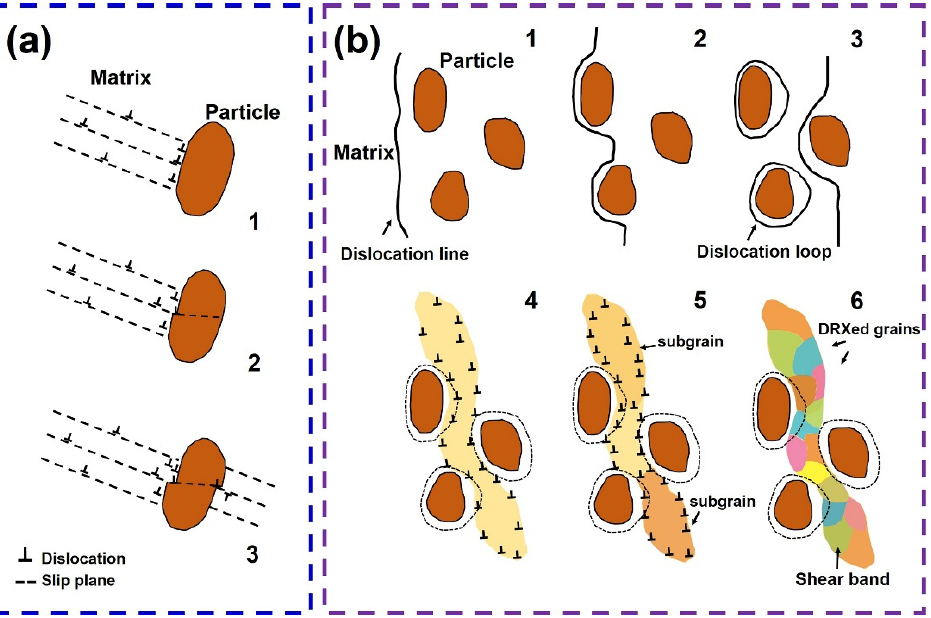
Figure 6. ( a ) Schematic diagram of dislocations cutting through the coherent nanoparticles, ( b1–b3 ) Schematic diagram of dislocations bypassing incoherent μ phase particles, where dislocation loops are left around μ phase particles; ( b4 ) dislocation accumulation at the particle boundaries and the formation of strain gradient due to GNDs; ( b5 ) the continuous accumulation of dislocations, which divides the high strain gradient region into subgrains; and ( b6 ) formation of DRXed grains accom ‐ panied with a reduction in dislocation density and occurrence of a shear band.